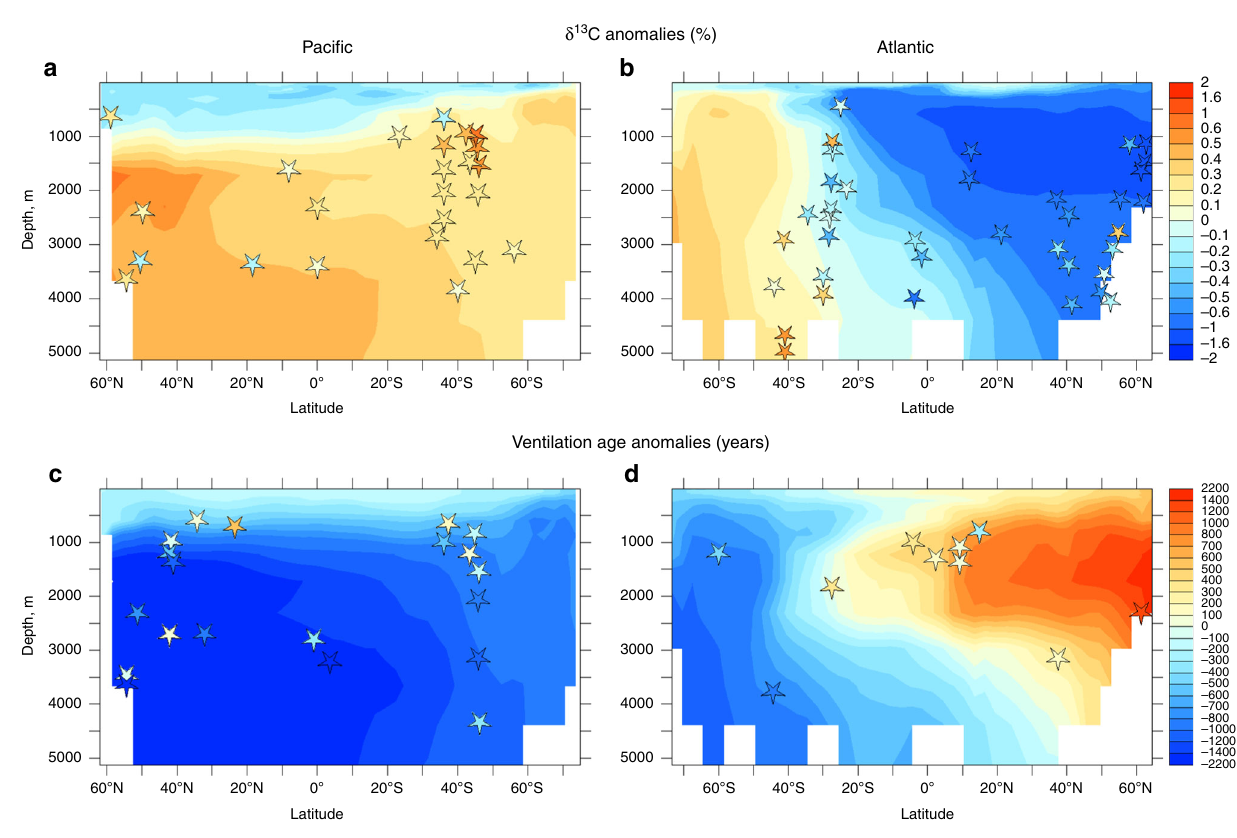
Fig. 4 Ocean carbon isotopes. Simulated a , b δ 13 C ( ‰ ) and c , d ventilation ages anomalies (years) at 16 ka compared to 19 ka, zonally averaged over a , c the Paci fi c and b , d the Atlantic in experiment LH1 – SO-SHW. Stars represent paleodata estimates: a , b benthic δ 13 C anomalies ( R = 0.77, p = 0.01, Supplementary Table 2) and c , d ventilation ages anomalies ( R = 0.52, p = 0.01, Supplementary Table